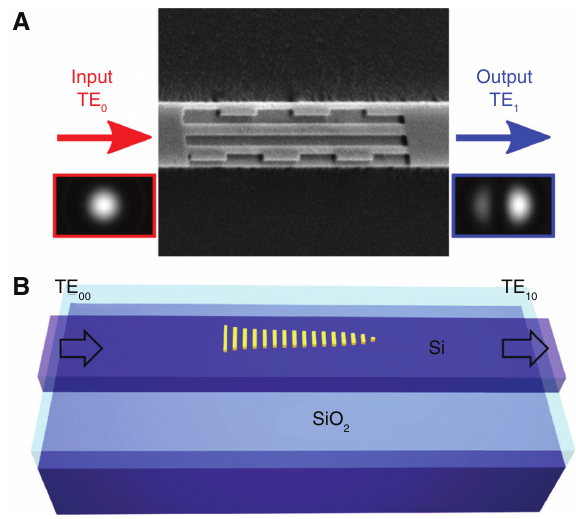
Figure 12: Schematic diagrams of waveguide mode converters assisted by metasurface/subwavelength structures. TE -to-TE mode converter with a (A) subwavelength feature and (B) 0 1 metasurface consisting of gold nanoantennas. The golden color represents gold. A is reprinted from Ohana et al. [55]. Copyright © 2016 by the American Chemical Society. Figure B is reprinted from Li et al. [56]. Copyright © 2017 by Springer